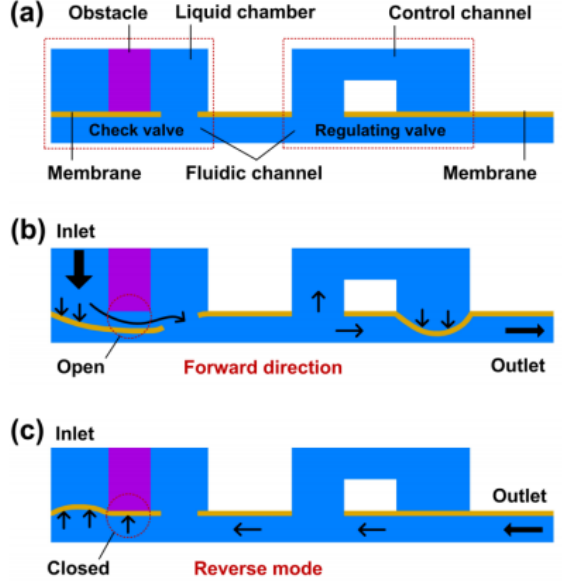
Figure 9. The working principle of the microfluidic device with a check valve and a flow regulating valve in PDMS. ( a ) Concept of the microchannel structure of the device at rest. ( b ) In the forward mode, the check valve is open and a flow regulating valve controls the liquid flowing through the microchannel. ( c ) In the reverse mode, the check valve is closed, and the flow is stopped (reprinted from Reference [46], Copyright MDPI).